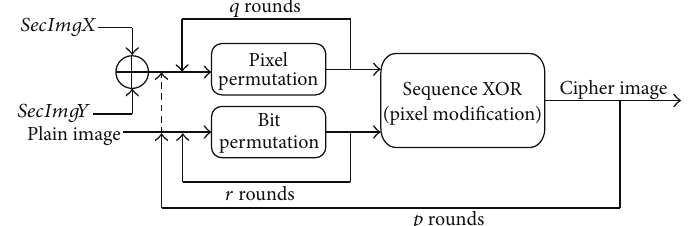
Figure 2: Proposed encryption scheme